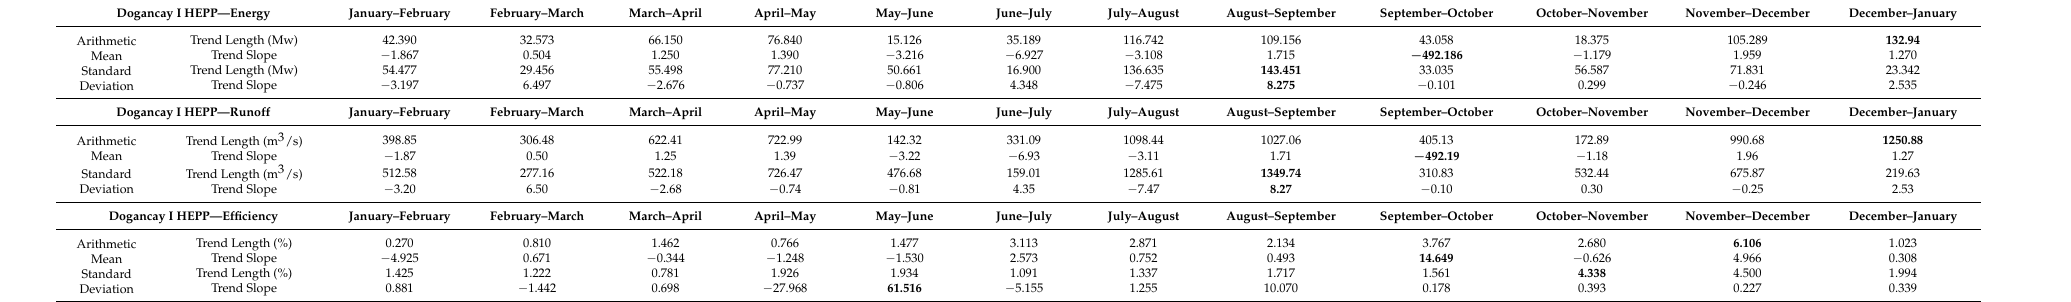
Table 4. Statistical Values of Arithmetic Mean and Standard Deviation of Dogancay I HEPP.